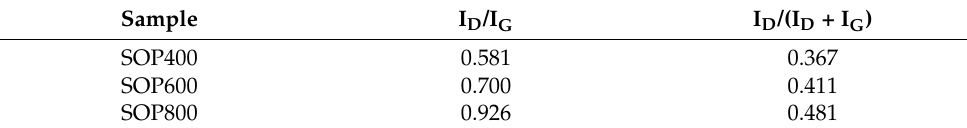
Figure 6. Raman spectra SOPRAW and biochars SOP400, SOP600, and SOP800. Table 3. Disorder degree of SOPRAW and biochars SOP400, SOP600, and SOP800.